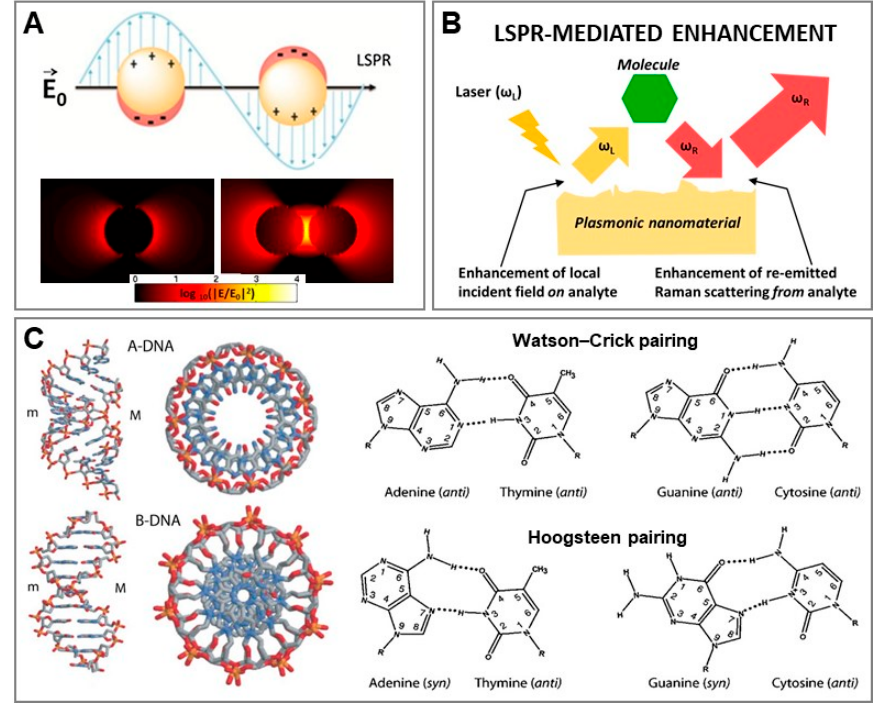
Figure 1. ( A ) Illustration of a localized surface plasmon resonance (LSPR). Calculated electrical fields for a 45 nm diameter silver nanoparticle and its corresponding dimer (interparticle gap, g = 1.31 nm) under a 514 nm excitation laser. Reprinted with permission from [8]. Copyright 2015, American Chemical Society. ( B ) Outline of the plasmonic-mediated enhancement of Raman scattering from a molecule located close to a nanostructured metallic surface (i.e., electromagnetic mechanism). Adapted with permission from [23]. Copyright 2012, Royal Society of Chemistry. ( C ) Structures of A-DNA and B-DNA duplexes (m = minor groove; M = major groove) and A–T and G–C base pairs (Watson-Crick and Hoogsteen pairing). Reproduced with permission from [24]. Copyright 2015, Wiley-VCH.